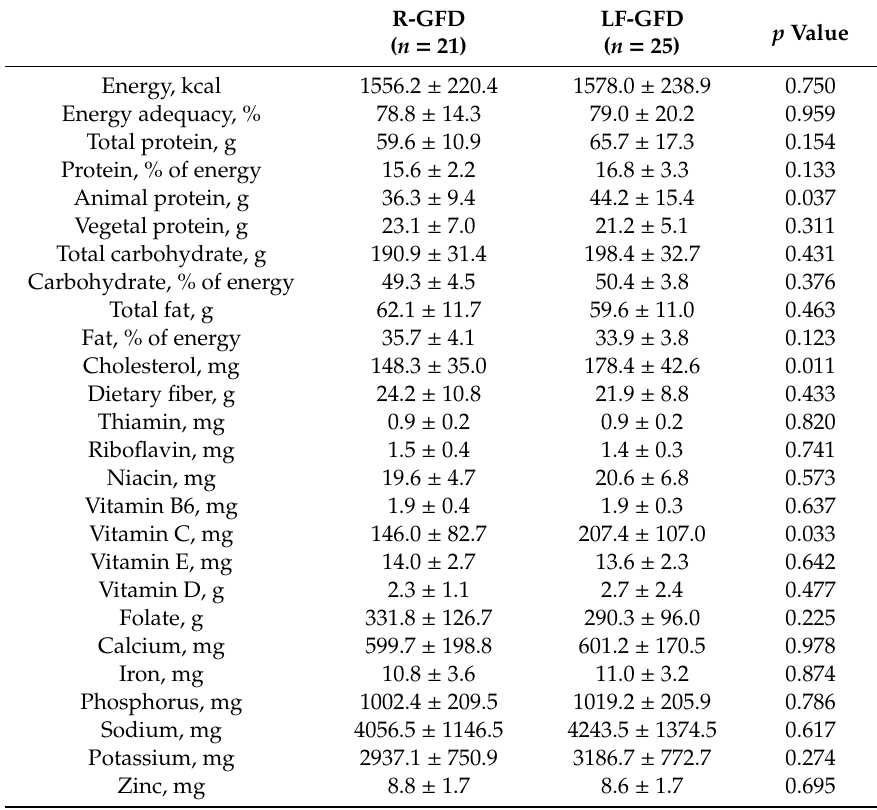
1 Data are shown as mean ± SD. p -value for comparison between the groups using independent samples t -test. R-GFD: Regular gluten-free diet, LF-GFD: Low-FODMAP gluten-free